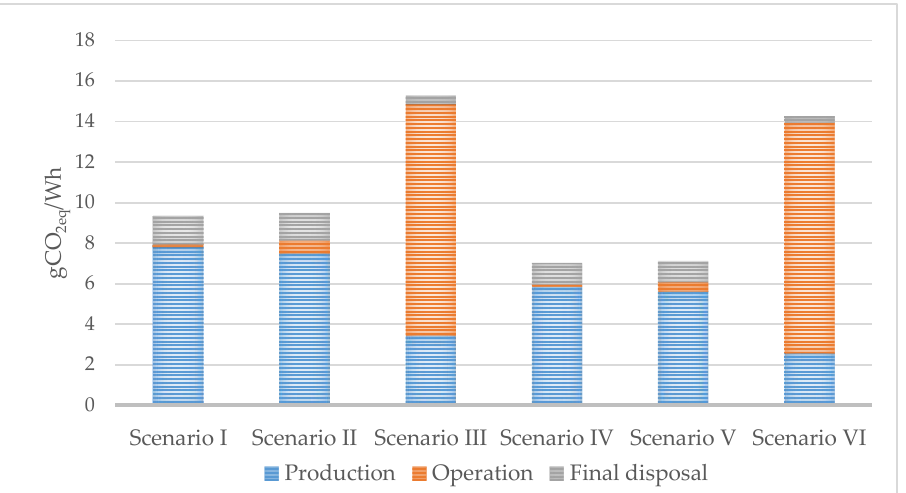
Figure 7. GWP results for TE cooling system including life cycle stages, gCO 2eq /Wh.